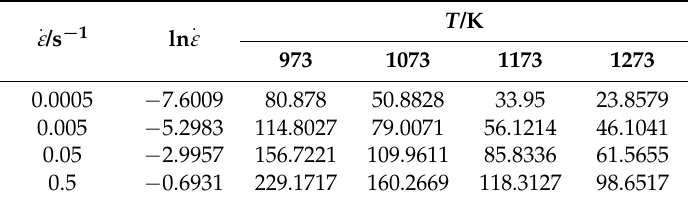
Table 1. Peak stress of NiTiCu SMA at the various strain rates and deformation temperatures (MPa). . . ε /s − 1 ln